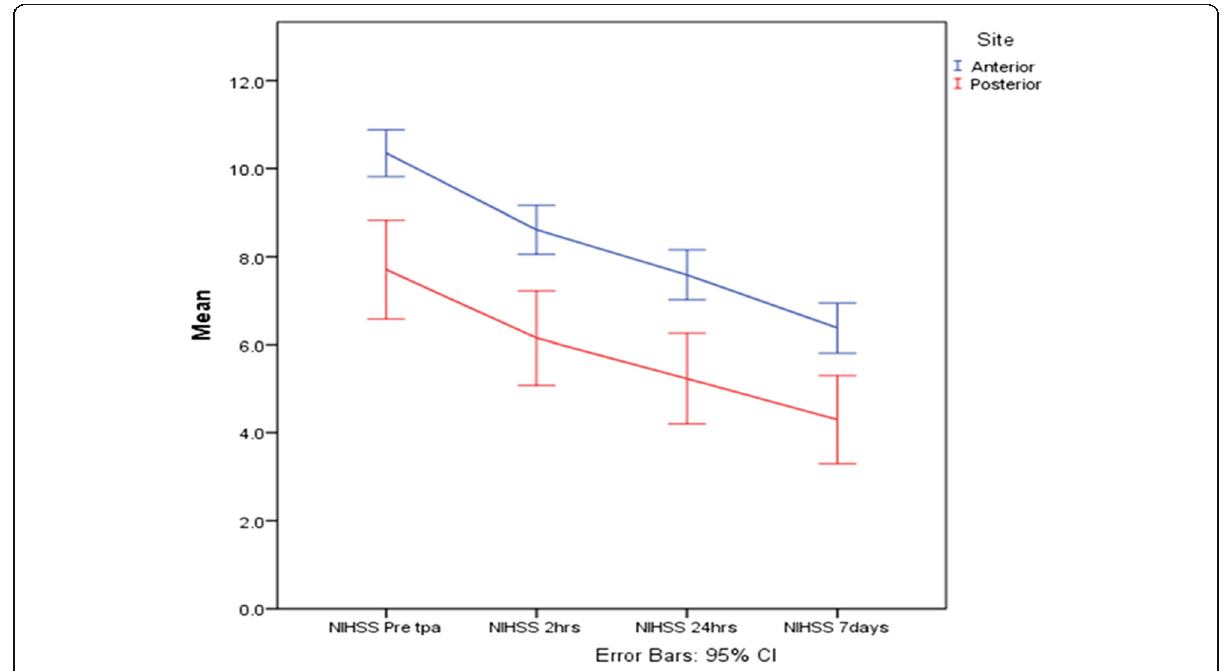
Fig. 2 The decline in the NIHSS score over serial time points within each of the study groups